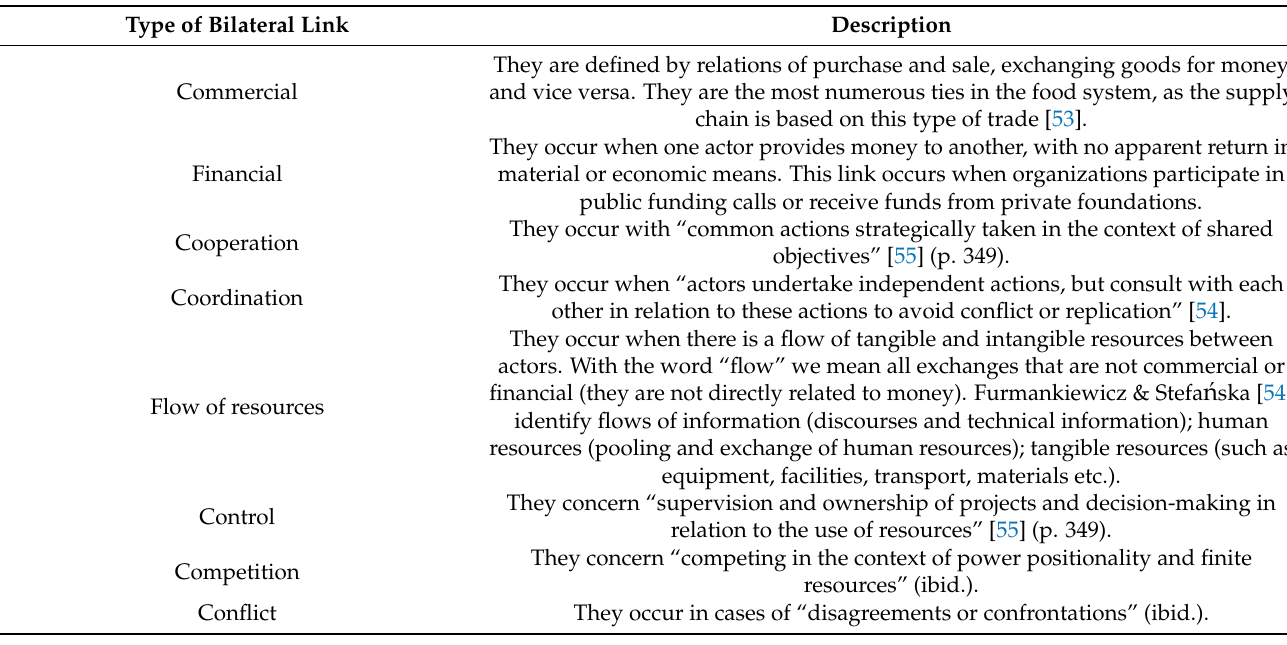
Table 2. The types of bilateral links considered for the third section.